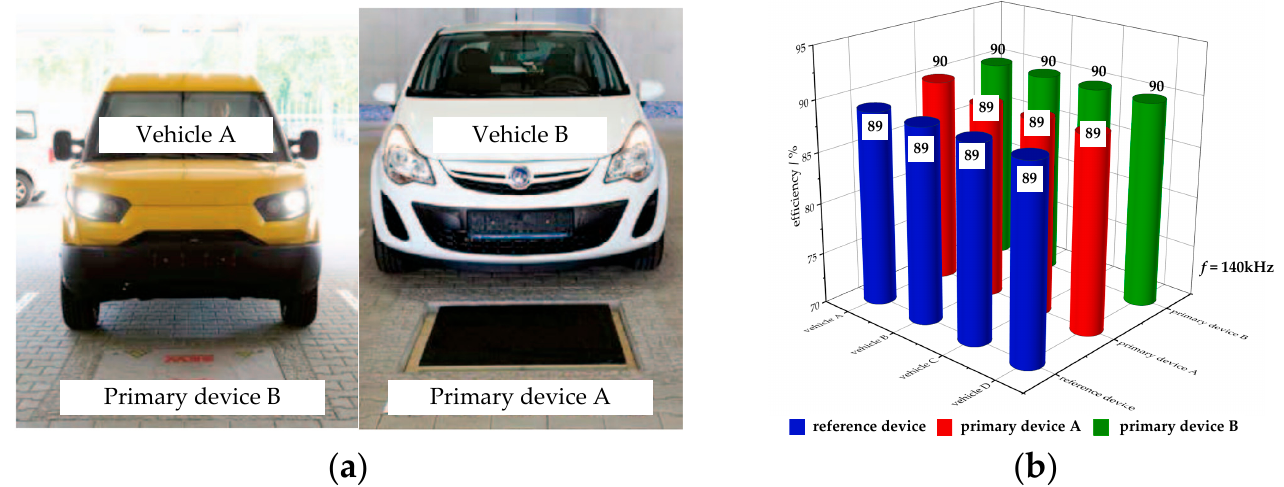
Figure 9. Interoperability test and results of products by German companies ( a ) Cross tests between